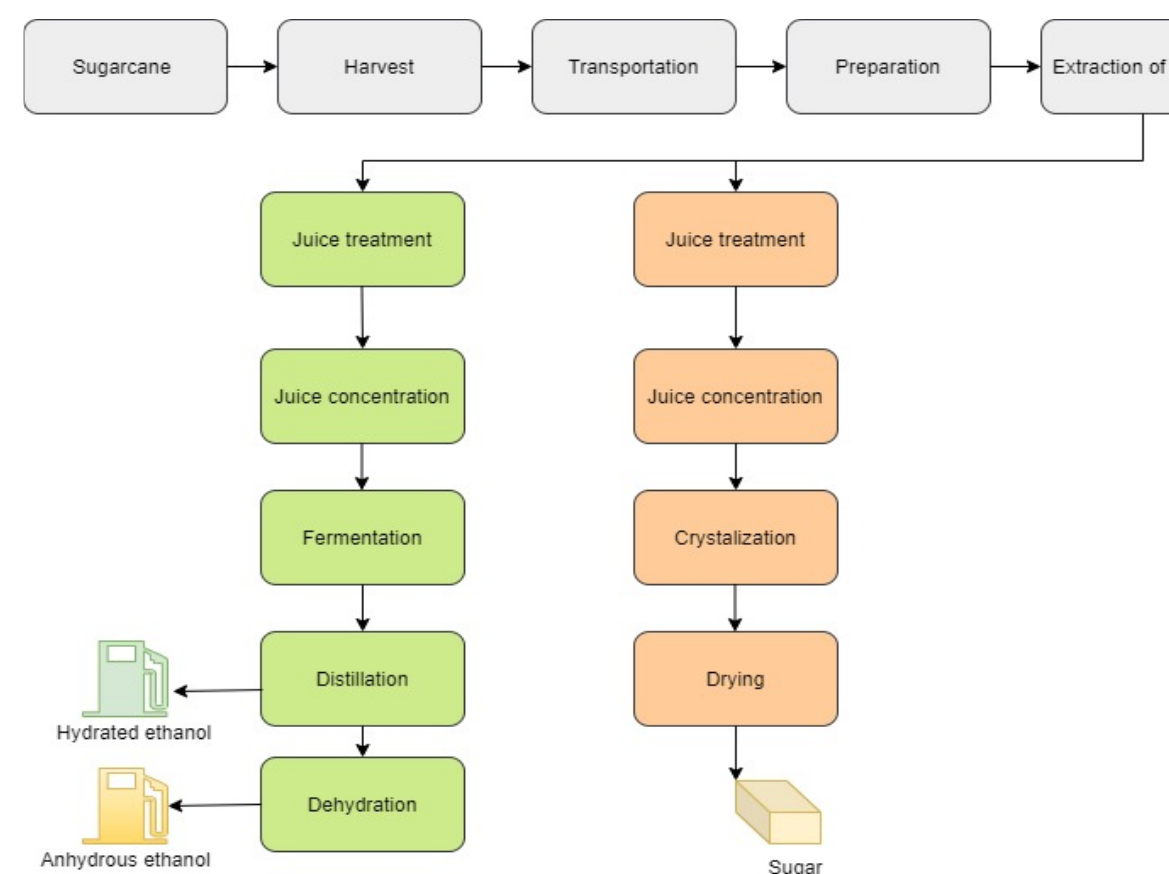
Figure 1. Production of ethanol and sugar from sugarcane.